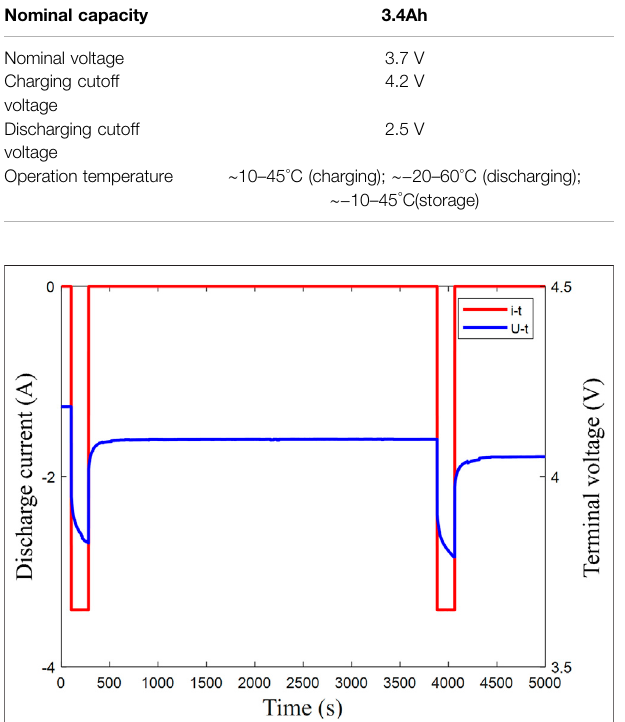
TABLE 1 | Parameters of the battery.